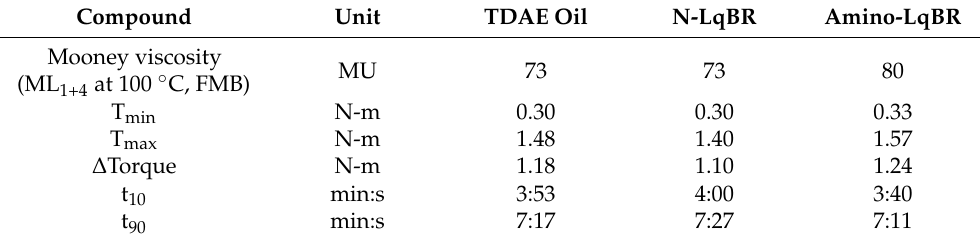
Table 6. Cure characteristics and Mooney viscosity of the compounds.